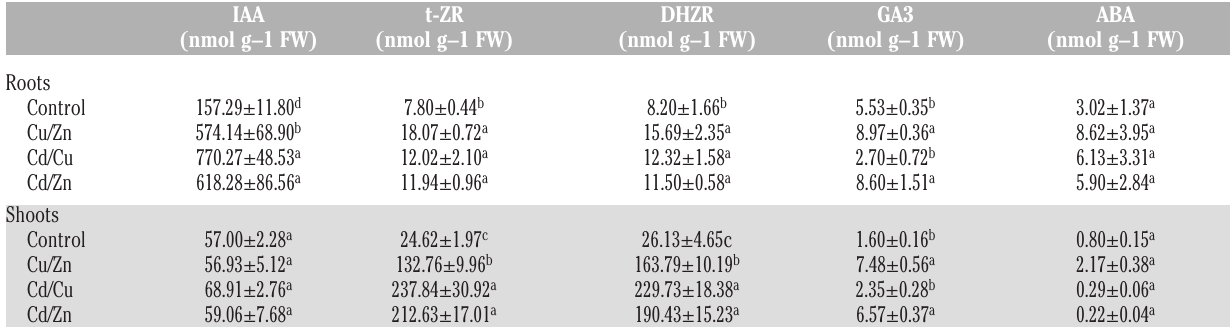
Table 4. Levels of indole-3-acetic acid (IAA), trans-zeatin riboside (t-ZR), dihydrozeatin riboside (DHZR), gibberellic acid (GA3) and abscisic acid (ABA) in roots and shoots of Arabidopsis seedlings not exposed to metals (Control) or exposed for 12 days to 5 µM CuSO and 150 µM ZnSO (Cu/Zn), 10 µM CdSO and 5 µM CuSO (Cd/Cu), and 10 µM CdSO 4 4 4